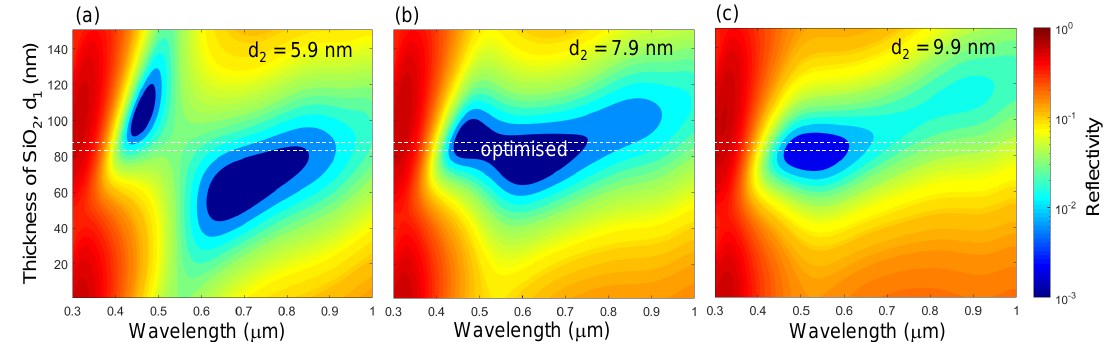
Figure A1. Simulations of the d 1 (y-axis) SiO layer-2 (Ti) was d 2 = 5.9 nm ( a ), d 2 = 7.9 nm ( b ) and d 2 = 9.9 nm ( c ) thick (structure is shown in Figure 2a); thickness d 3 = 93.7 nm. Normal incidence θ = 0 ◦